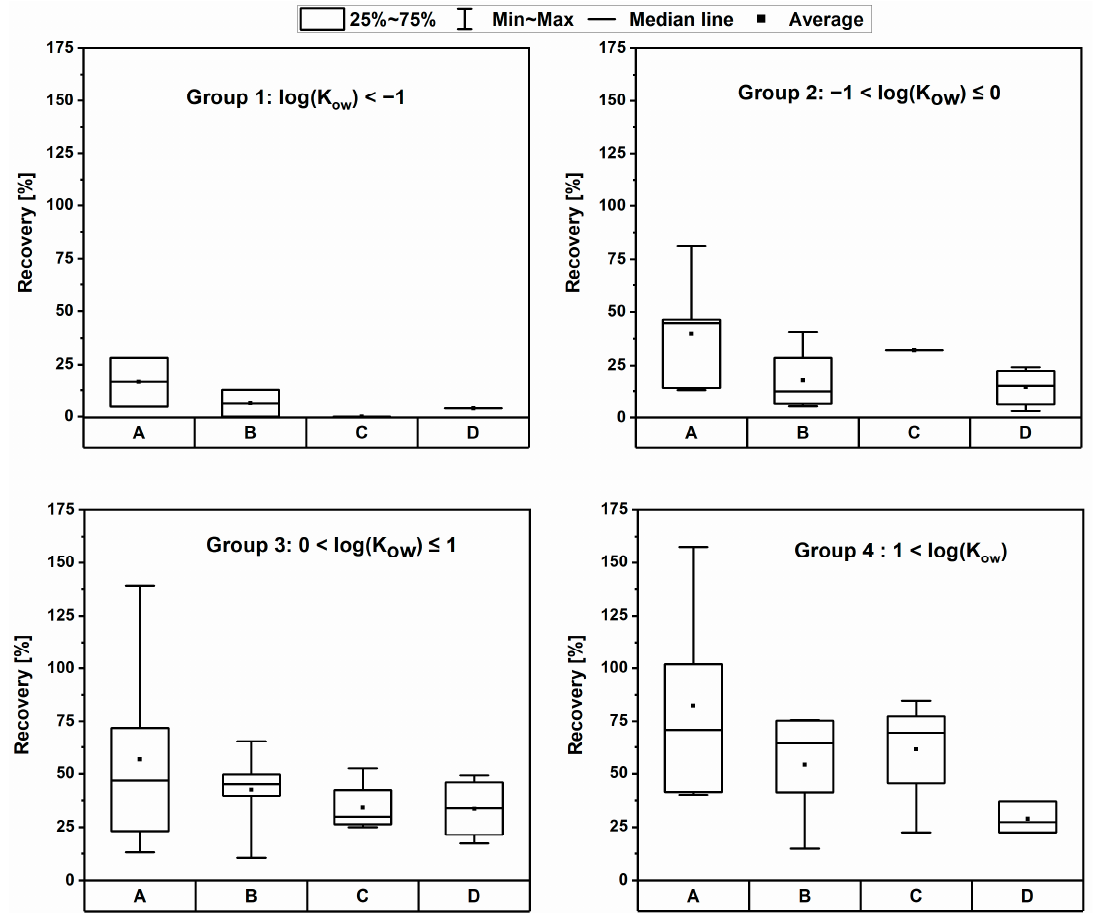
Figure 2. The boxplots for the recoveries of protocols A to D. ABs were regrouped according to their log(Kow) values in the four groups. The recoveries for protocols E and F are presented in Figure 3 and for protocol G in Table 2.